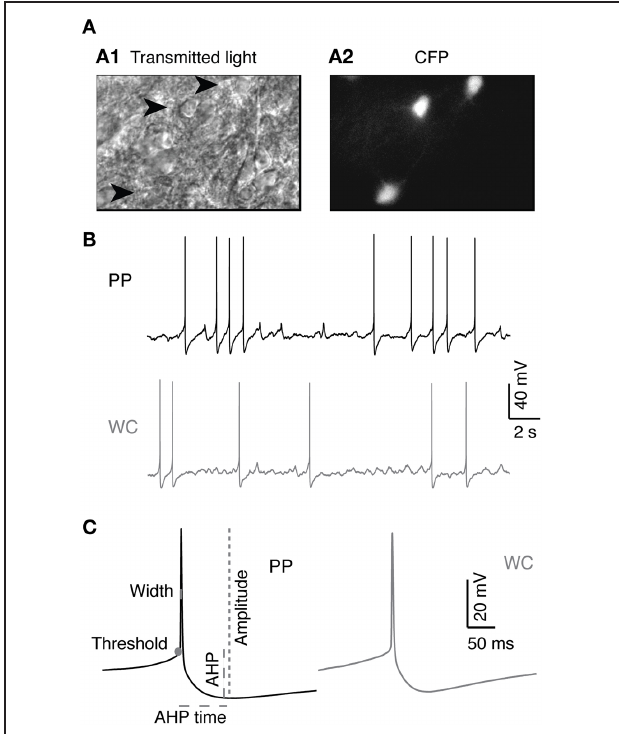
FIGURE 1 | V2a INs in PP and WC recordings. (A) Identification of V2a interneurons in a neonatal spinal cord slice. ( A1 ) Chx10-eCFP neurons from a P3 mouse spinal cord slice seen under infrared transmitted light. Arrowheads indicate V2a INs. (A2) The same region under epifluorescent illumination revealing the CFP-labeled V2a INs. (B) Sample traces from PP and WC recordings. (C) Action potentials (average of 10 APs) from PP and WC recordings. On the PP action potential, schematics show the measurements of threshold, amplitude, width, afterhyperpolarization